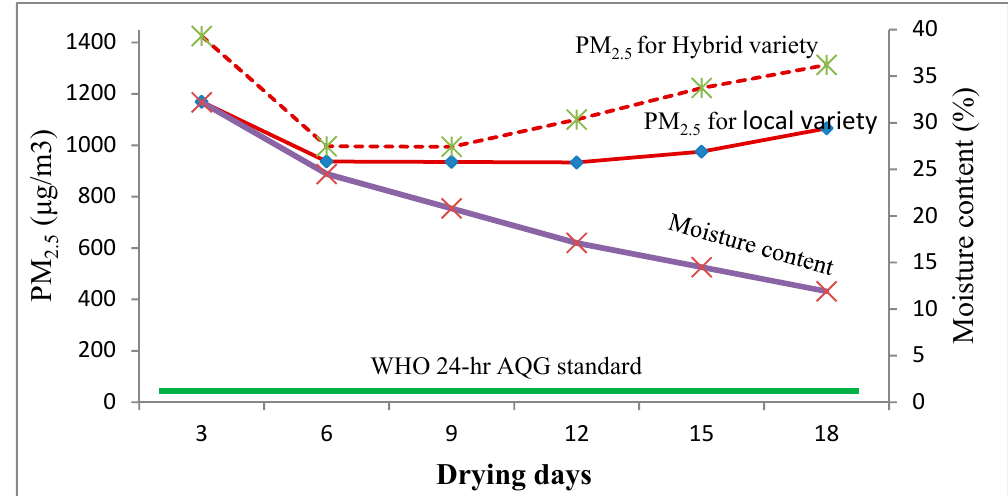
Figure 9. Graphs of PM and moisture content of the hybrid and local coconut